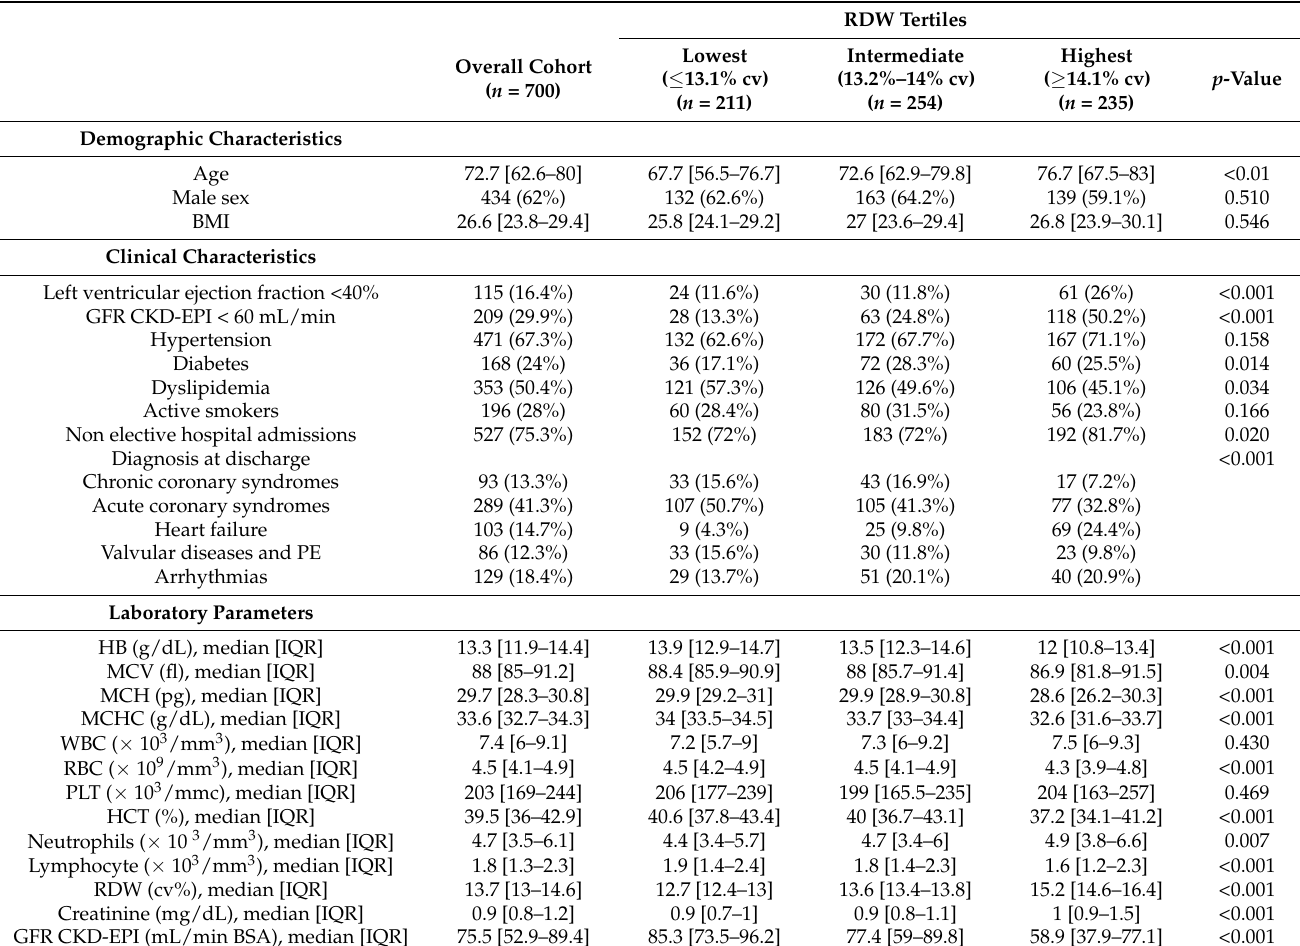
Table 1. Demographic, clinical, and laboratory characteristics of patients enrolled.